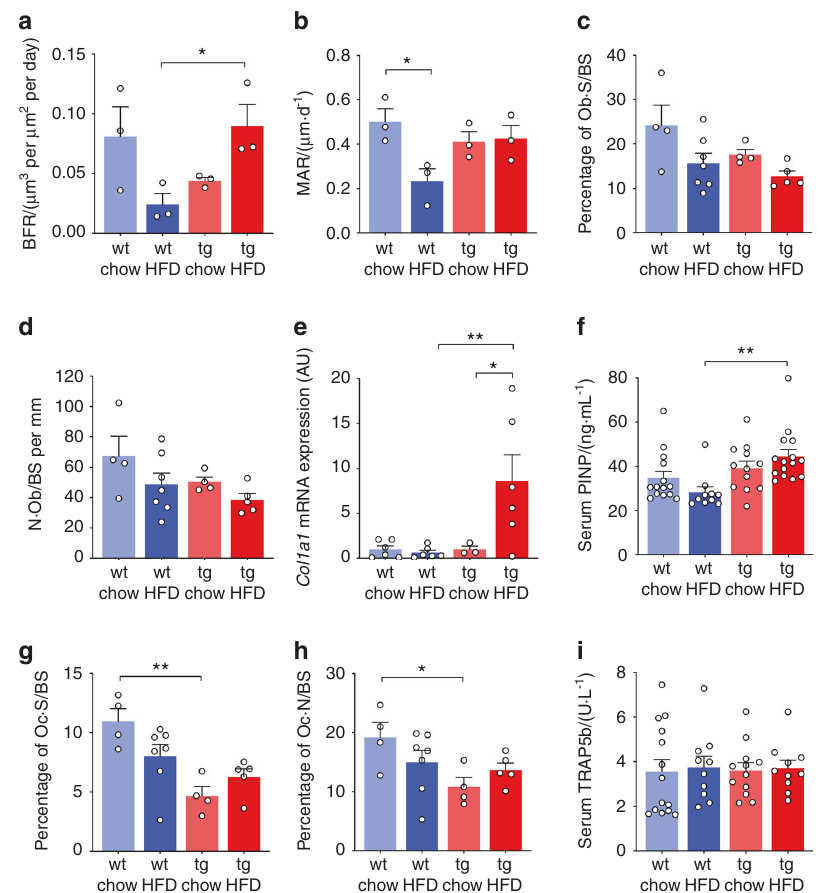
Fig. 3 HFD feeding for 18 weeks reduced bone formation in wild-type mice but not in HSD2 OB/OCY -tg mice. The results are shown as scatterplots, with the mean ± SEM shown in columns. a Bone formation rate (BFR) and b mineral apposition rate (MAR) in wild-type (wt) and HSD2 OB/OCY -tg (tg) mice fed either chow or HFD for 18 weeks. In each case, there was a signi fi cant diet× genotype interaction (for BFR, F 1,8 = 10.16, P = 0.013; for MAR: F 1,8 = 6.68, P = 0.032). c Trabecular osteoblast surface (%): the effect of diet was signi fi cant ( F 1,16 = 6.74, P = 0.020). d Osteoblast number. e Bone mRNA expression of collagen, type 1, alpha 1 ( Col1a1 ): the diet × genotype interaction was signi fi cant ( F 1,17 = 5.010, P = 0.039). f Serum procollagen type I N-terminal propeptide (P1NP) concentrations: the effect of genotype was highly signi fi cant ( F 1,47 = 11.47, P = 0.001 4). g Osteoclast surface: the diet × genotype interaction was signi fi cant ( F 1,16 = 5.400, P = 0.034). h Osteoclast number: the effect of genotype was signi fi cant ( F 1,16 = 5.932, P = 0.027). i Serum tartrate-resistant acid phosphatase 5b (TRAP5b) concentrations. In all cases, signi fi cance was determined using two-way ANOVA, with the Tukey ’ s multiple comparison test used for post hoc testing, * P < 0.05 and ** P < 0.01 for transgenic mice (Fig. 5b, right graph). Closer examination of DMP1- In HSD2 OB/OCY -tg mice, but not wild-type mice, glucose uptake stained osteocytes also indicated that the number of DMP1-positive into bone was increased 4.5-fold in response to HFD feeding ( P < osteocyte dendrites was reduced in wild-type, but not HSD2 OB/OCY - 0.05, Fig. 4g). Increased glucose uptake in bone was not attributable to differences in the mRNA expression of the glucose tg mice, when fed HFD (Fig. 5a). transporters Glut1 and Glut4 (Fig. S3). Interestingly, glucose uptake Next, we examined the potential for HFD-induced deterioration into other insulin-sensitive tissues (brown and gonadal white of the LCN. 36 Analysis of the LCN and its components in silver- adipose tissue, quadriceps muscle) was not altered (Fig. 4h – j). stained sections of tibiae from the above mice (Fig. 5c, d) Therefore, the HFD-induced increase in bone formation seen in indicated that HFD feeding produced differential effects between HSD2 OB/OCY -tg mice was supported by a marked increase in skeletal glucose uptake. HSD2 OB/OCY -tg mice were protected against HFD-induced loss of the lacunocanalicular network (LCN) The 11 β -HSD2 transgene is expressed in both osteocytes and osteoblasts in HSD2 OB/OCY -tg mice. Since the majority (90% – 95%) of cells in bone are osteocytes, we stained tibial sections from chow- and HFD-fed wild-type and HSD2 OB/OCY -tg mice for expression of the osteocyte marker dentin matrix protein-1 (DMP1) (Fig. 5a). In wild- type mice, HFD feeding led to a 53% reduction in the number of DMP1-positive osteocytes ( P < 0.01, Fig. 5b, left graph), but this effect was not observed in HSD2 OB/OCY -tg mice. Diet did not affect lipotoxicity. 37 After 8 weeks, and more so after 18 weeks of HFD the number of DMP1-negative osteocytes in either wild-type or